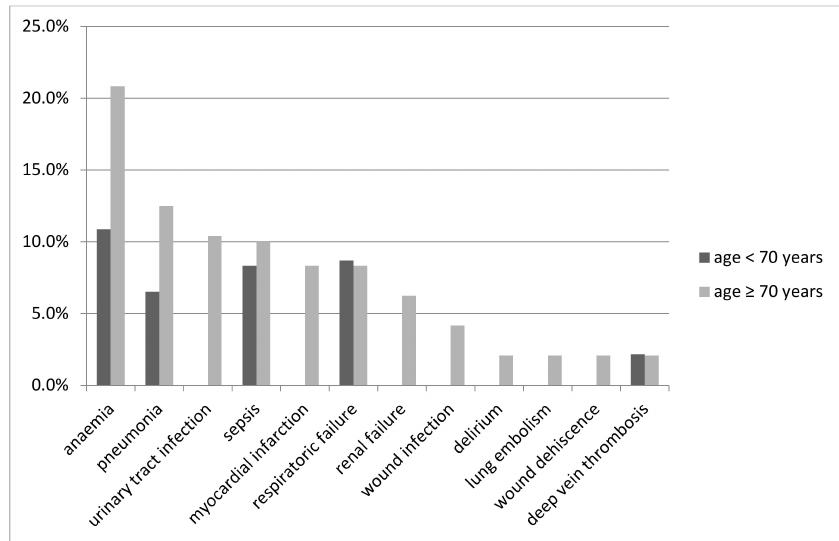
Figure 4. Type of complication for the two age